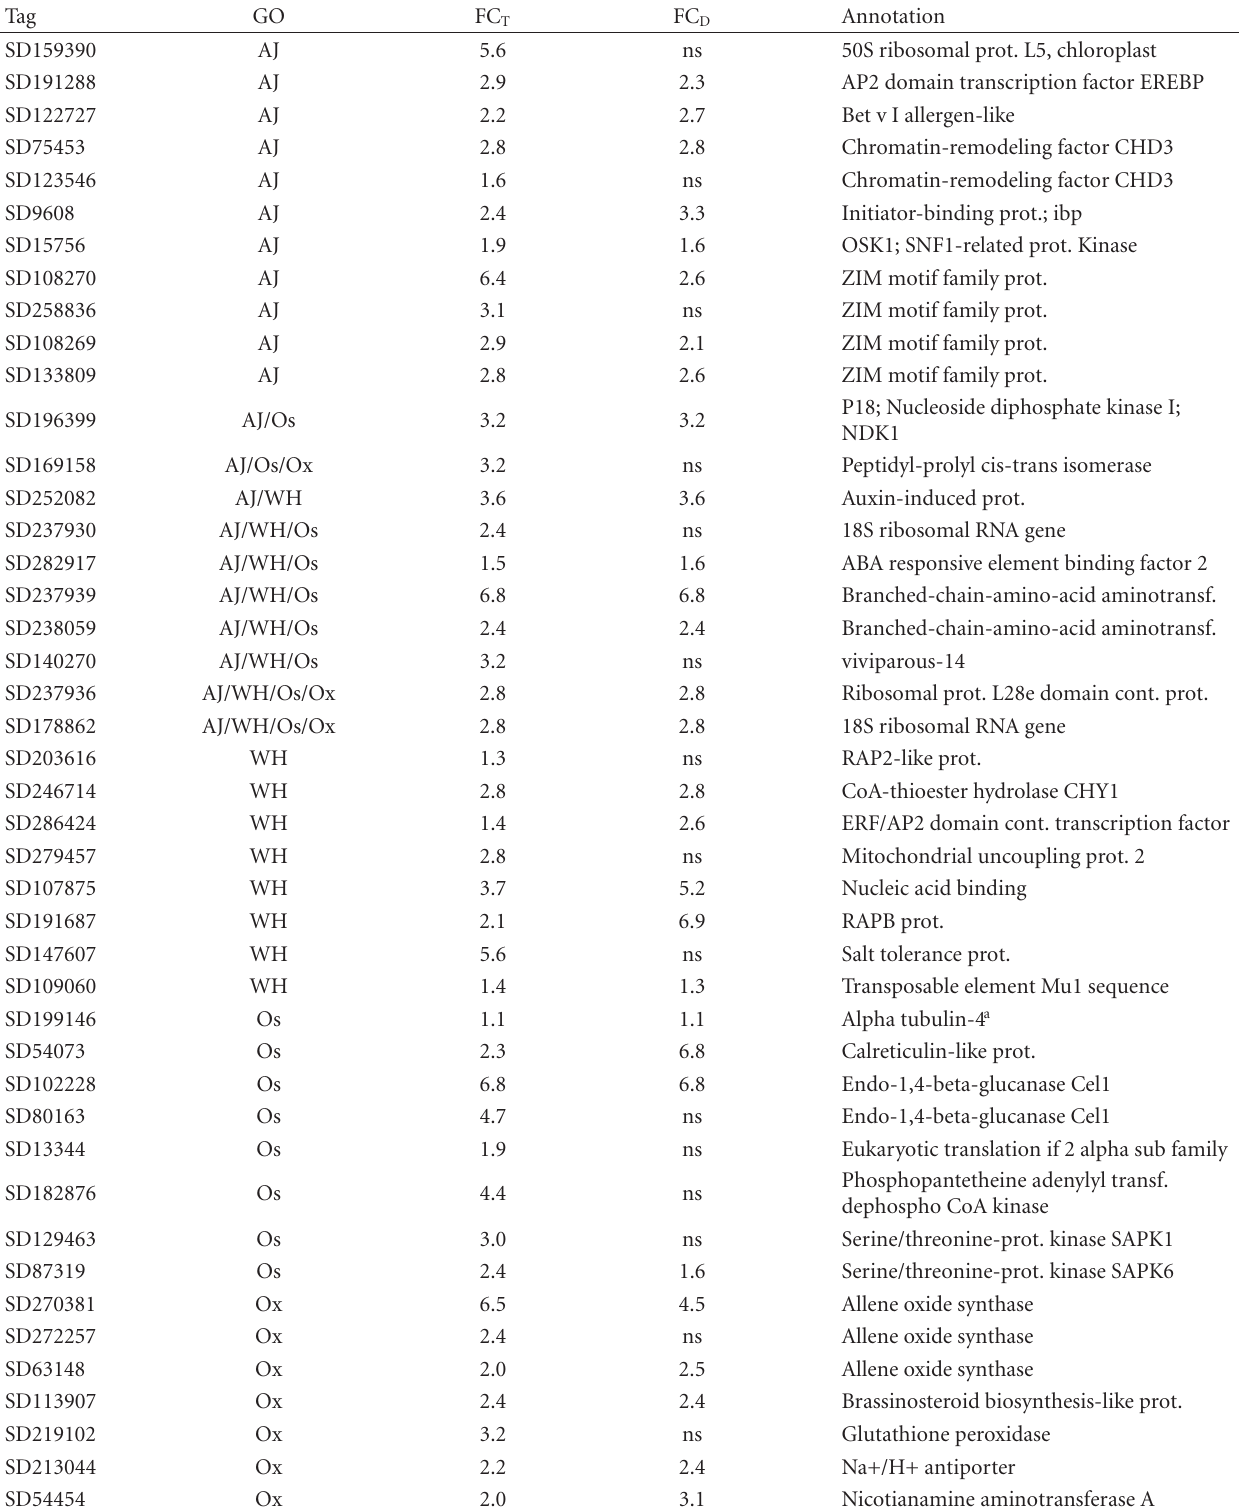
Table 3: Upregulated SuperSAGE tags associated via Gene Ontology (GO) to abiotic stress, with fold change for T (FC T = TD/TC) and D (FC D = TD/SD) comparisons for tag frequencies in the sugarcane roots libraries, as well as the annotation of the best aligned